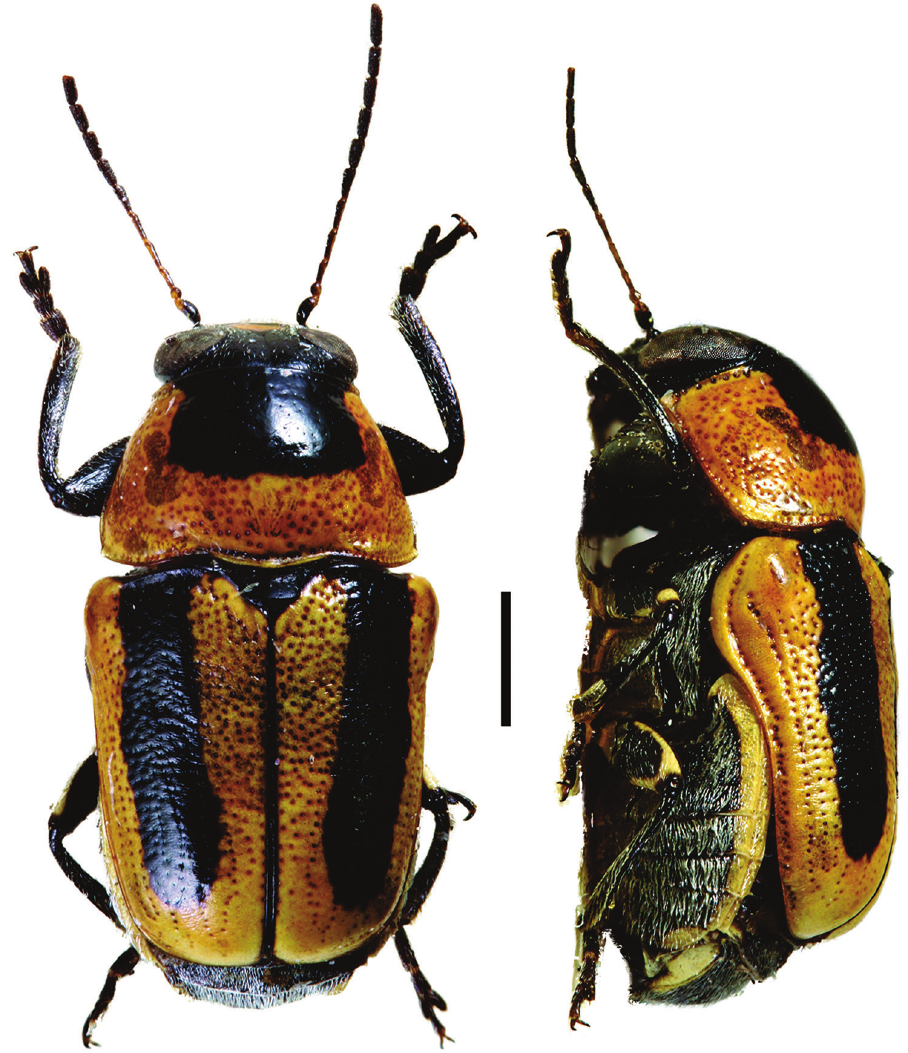
Figure 24. Griburius cultus (Suffrian) (4) , left: habitus (dorsal view), right: habitus (lateral view). Distribution. Nearctic and